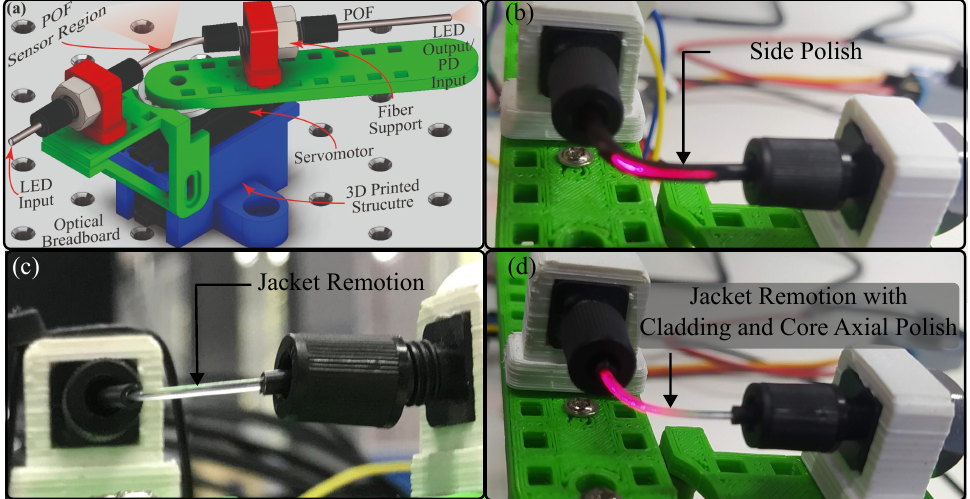
Figure 4. Test bench for the angle sensor and first position per fiber configuration. ( a ) Test bench CAD. ( b ) Fiber sensor with side polish. ( c ) Fiber sensor jacket remotion. ( d ) Fiber sensor jacket remotion with cladding and core axial